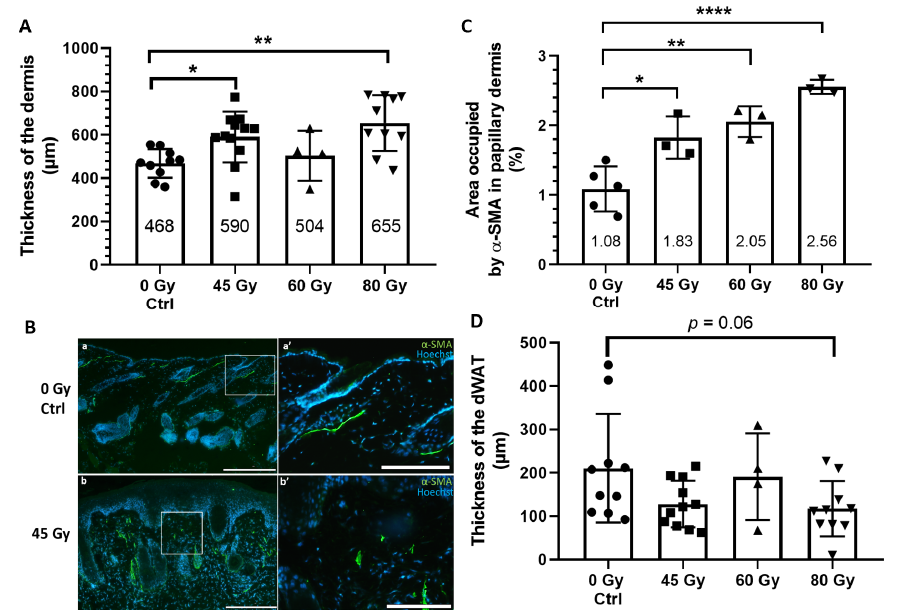
Figure 5. Impact on connective tissue compartments 28 days after irradiation. ( A ) Mean thickness of dermis. ( B ) Immunolabeling for α -SMA on ( a ) a representative skin biopsy of non-irradiated control skin and ( b ) 28 days after irradiation with a 45 Gy radiation dose. ( a‘ , b’ ) are magnifications of the areas delimited by the white boxes in ( a , b ). Bars ( a , b ) = 500 µm; ( a’ , b’ ) = 200 µm. Nuclei were stained with Hoechst. ( C ) Quantification of α -SMA labeling associated with the presence of myofibroblasts in the papillary dermis 28 days after irradiation. ( D ) Mean thickness of the dermal white adipose tissue layer (dWAT). Statistics: mean ± SD. n = 3–16 mice/group, One-way ANOVA with Dunnett’s multiple comparison tests * p < 0.05, ** p < 0.01, **** p < 0.0001.